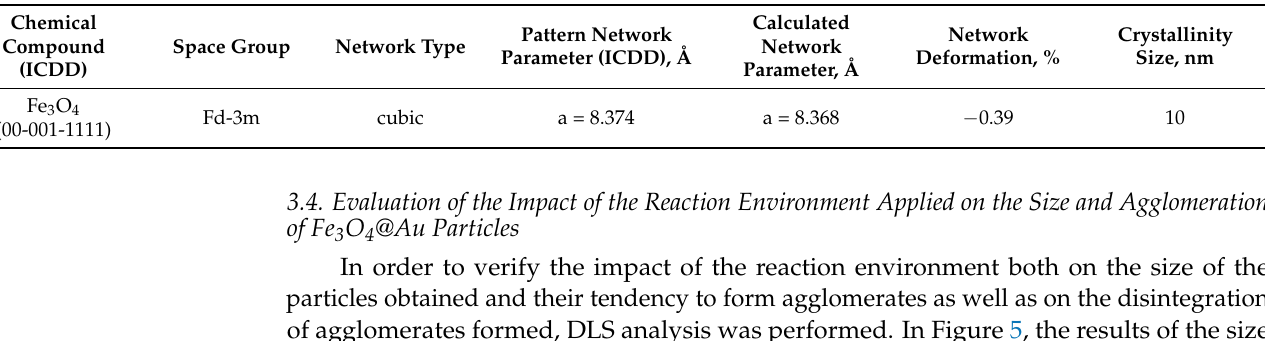
Figure 4. XRD pattern of magnetic nanoparticles washed with 0.1 M sodium citrate solution. Table 1. Parameters determining the crystallinity of obtained particles.